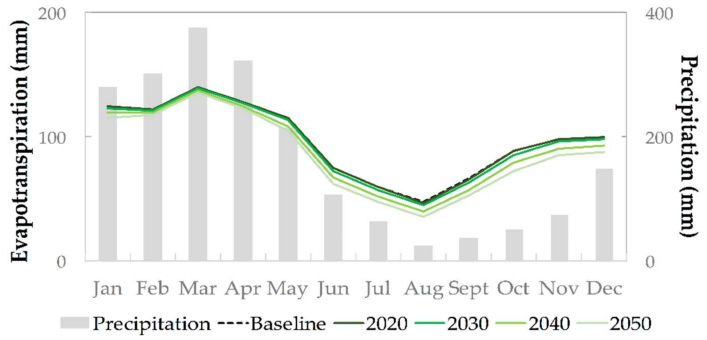
Figure 7. Monthly average simulated evapotranspiration for 2020, 2030, 2040, 2050, and the